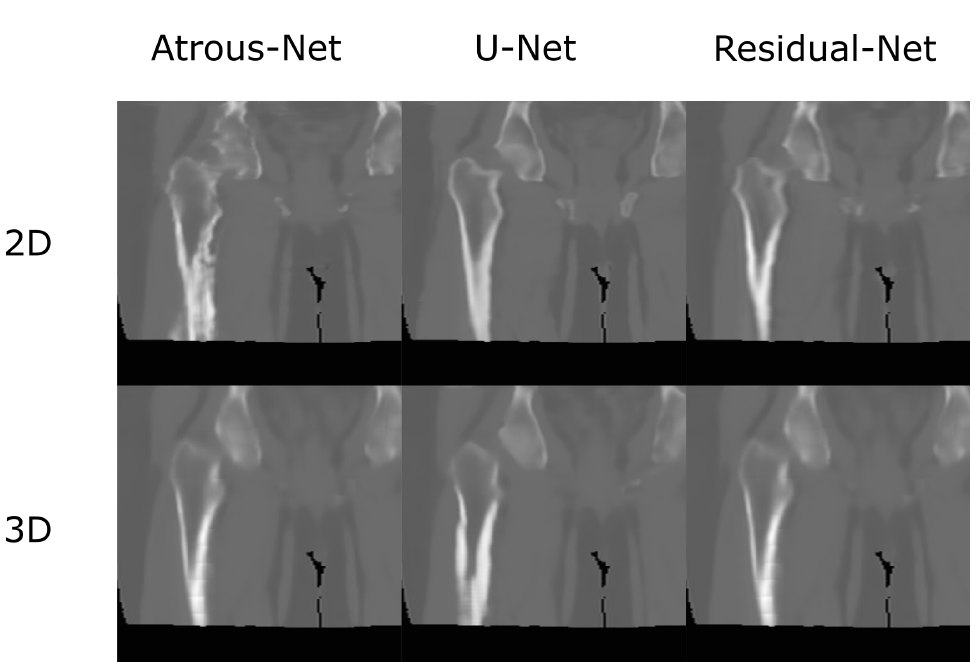
Figure 13. Comparison in the sagittal and coronal direction for the pelvis between the 2D and 3D